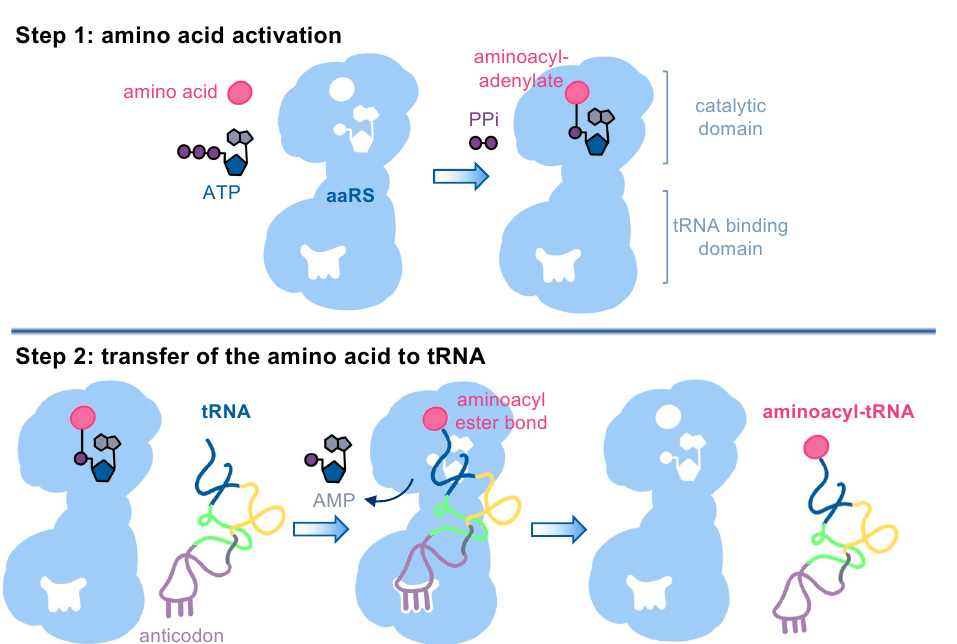
Figure 1. Aminoacylation of tRNAs occurs in a two-step process. Step 1: In the catalytic domain of the aminoacyl-tRNA synthetase (aaRS), a reaction between an amino acid and an ATP molecule results in an aminoacyl-AMP intermediate and releases a pyrophosphate (PPi). Step 2: tRNA recognition is aaRS-specific and involves binding of the acceptor stem, as well as tRNA identity elements such as the anticodon loop, variable loop, or other identity elements in the tRNA. In the aaRS catalytic domain, the amino acid is transferred from the aminoacyl-AMP intermediate to the cognate tRNA molecule. The aminoacyl-tRNA product is released from the enzyme.